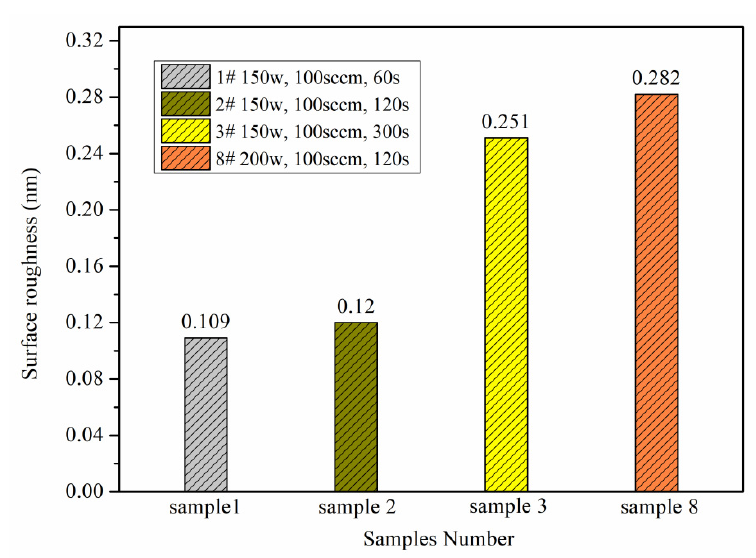
Figure 4. Effect of O 2 plasma activation process on surface roughness.